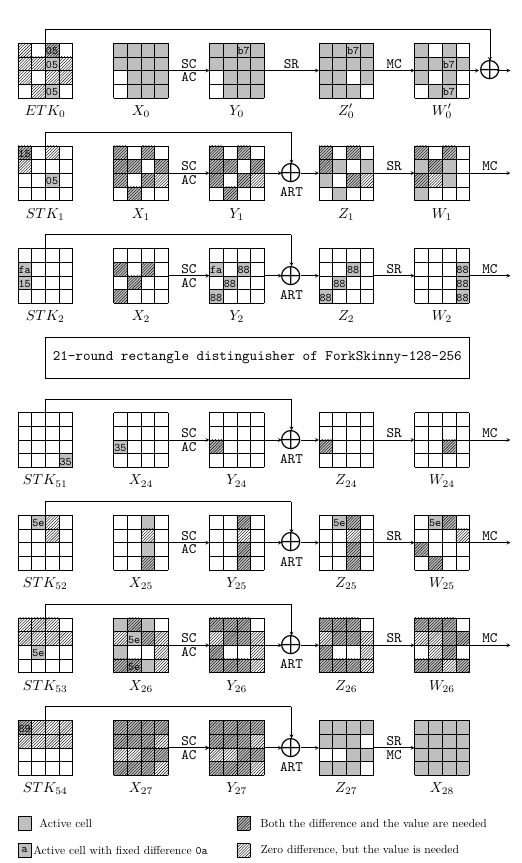
Figure 12: The 28-round attack against ForkSkinny-128-256 (256-bit